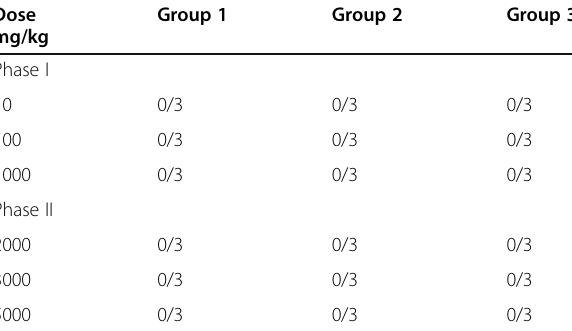
Table 2 Acute toxicity study of aqueous methanolic extract of A. inermis showing death recorded